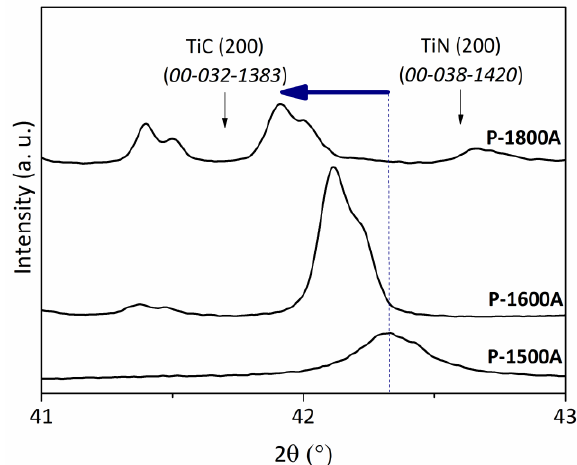
Figure 16. Evolution of the (200) peak position in the X-ray patterns of P-1500A , P-1600A and P-1800A samples.